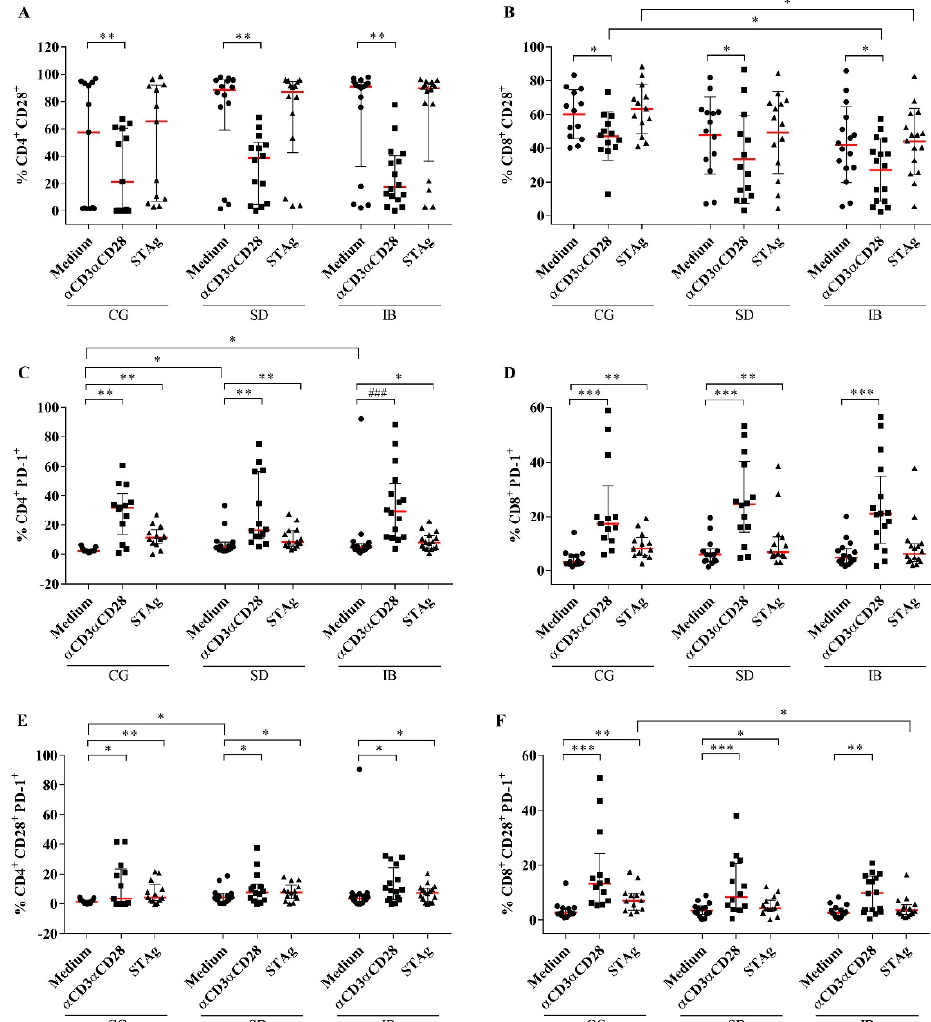
Figure 4. Activation and exhaustion of CD4 + and CD8 + T lymphocytes, assessed by the expression of CD28 and PD-1 cell surface receptors. ( A ) Percentage of CD4 + CD28 + , ( B ) CD8 + CD28 + , ( C ) CD4 + PD-1 + , ( D ) CD8 + PD-1 + , ( E ) CD4 + CD28 + PD-1 + , and ( F ) CD8 + CD28 + PD-1 + after 96 h of stimulus with anti-CD3 and anti-CD28, STAg, and absence of stimulus in the CG and SD and IB group, by flow cytometry. Analysis between stimuli by Wilcoxon ( A , C – F ) and by paired T -test ( B ) and among groups by Kruskal–Wallis ( A , C – F ) and ordinary one-way ANOVA ( B ). The horizontal bars represent the medians with interquartile ranges or means with standard deviation. Statistically significant data, * p < 0.05, ** p < 0.005, *** p < 0.0005, and ### p <